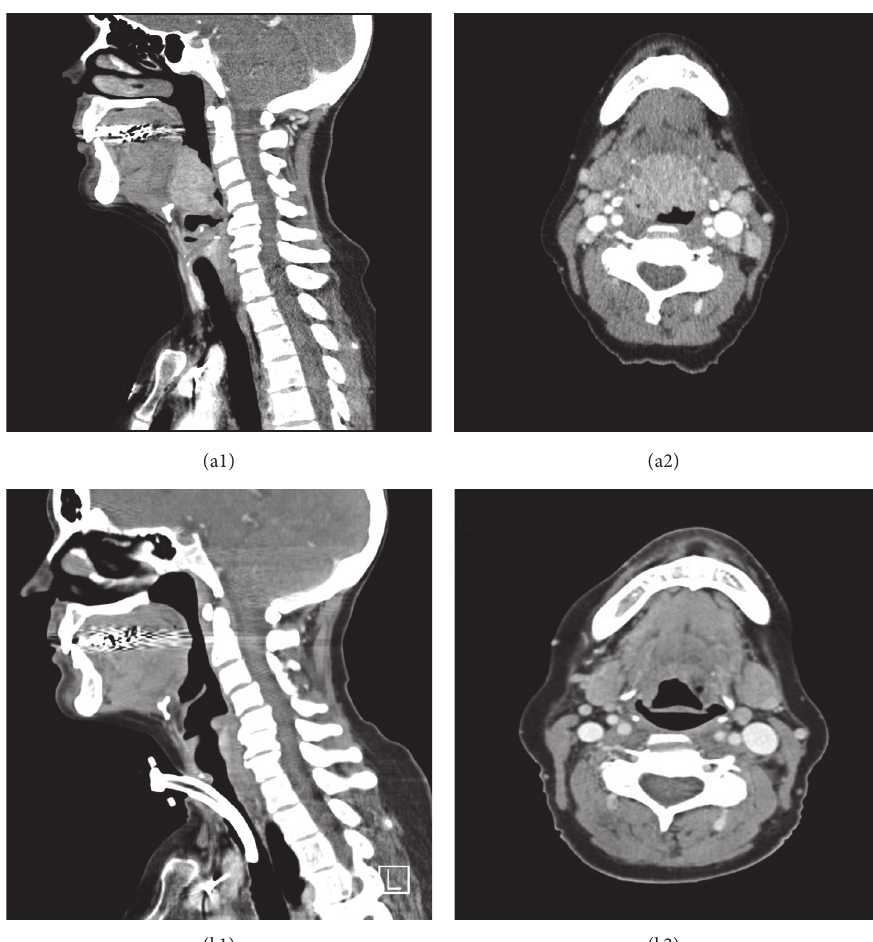
Figure 2: Interval change in size of BOT mass on contrasted CT scan of the head and neck before (a1 and a2) and after (b1 and b2) two cycles of bendamustine and